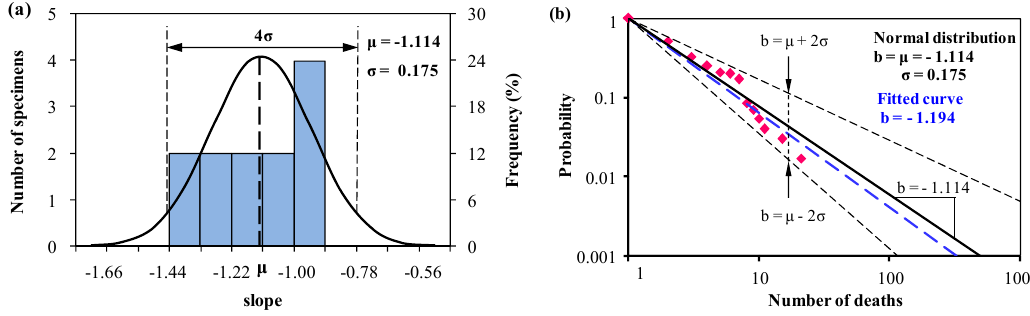
Figure 3. ( a ) Normal distribution analysis of the slope b i , and ( b ) predictions from Equation (1) and Equation (3) based on the normal distribution analysis of b i in ( a ) for Group 1 together with the statistical data (1931–2004) available in Oggero et al. [11].